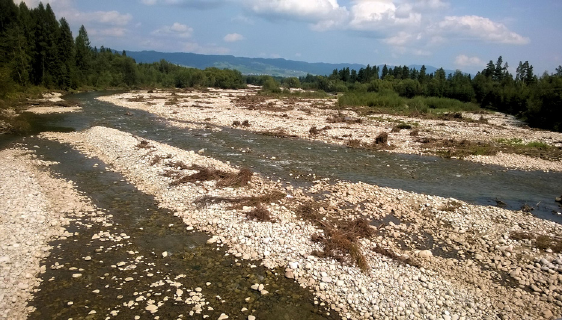
Fig. 5. The braided channel of the Białka river near Nowa Biała village. Photo: A.